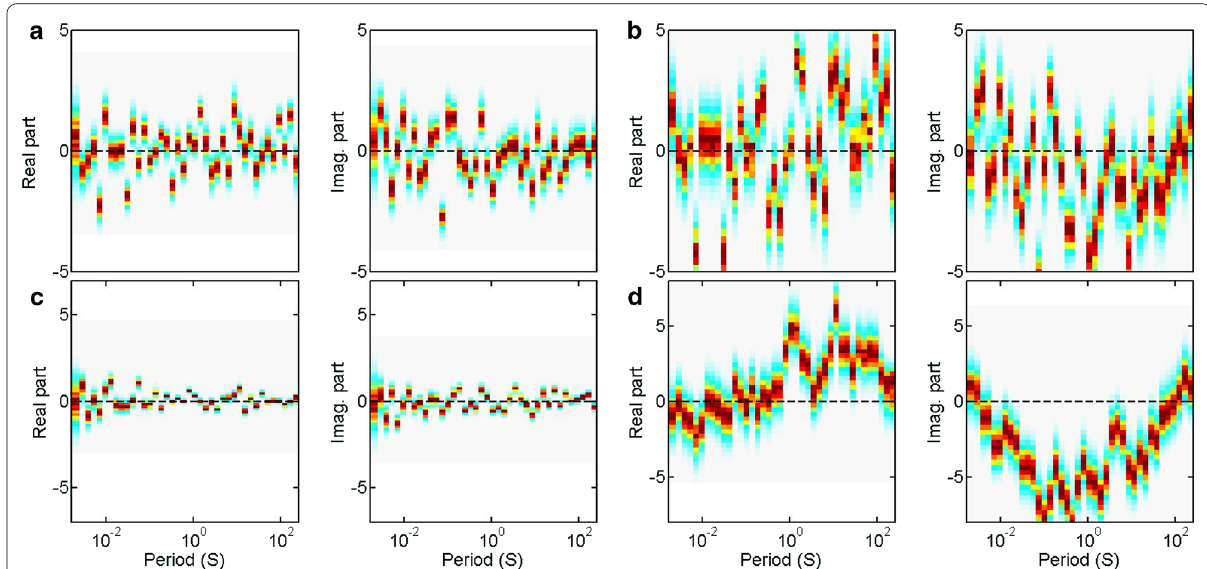
Fig. 3 Density maps of the posterior data residuals normalized by sample standard deviations for the eight-layer model from the inversions ( a , c ) with and ( b , d ) without considering error correlations. The upper panels are for the AR(1) parameter a